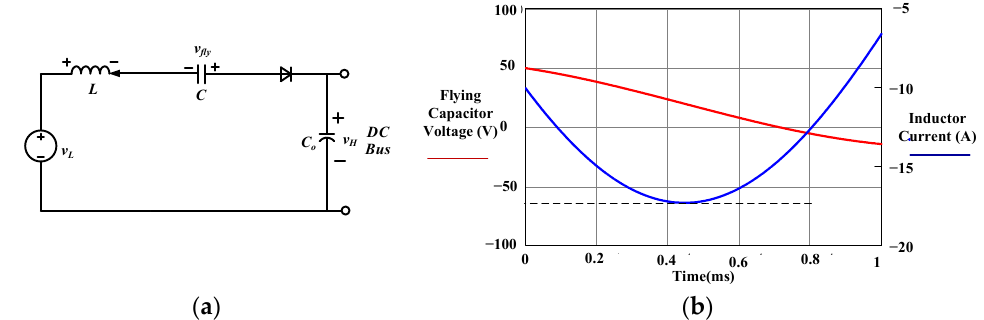
Figure 11. The analysis of the stages under S 3 fault. ( a ) Equivalent circuit; ( b ) the simulation curve (V L 80 V, V H 100 V, initial value of I L -10 A).